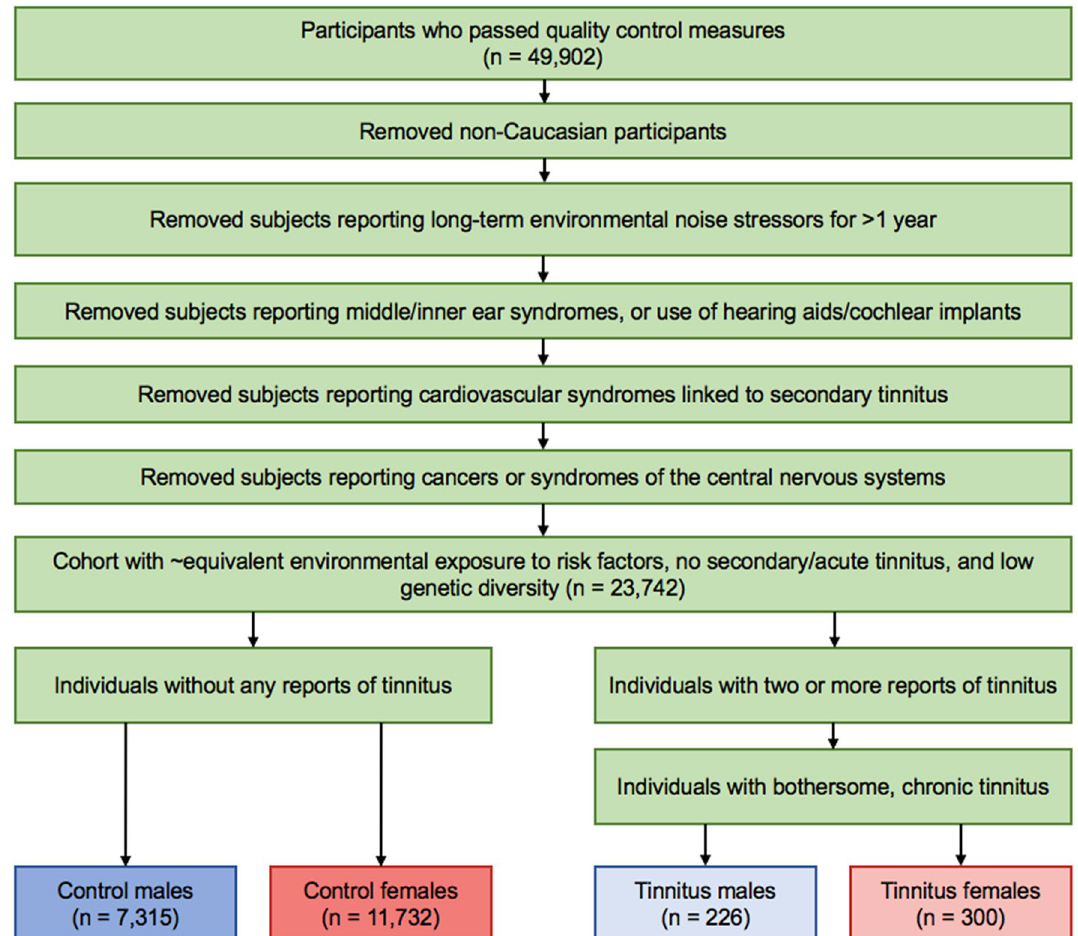
Figure 2. Reductionist workflow of phenotypic sorting measures used to define tinnitus and control cohorts. Participants were screened based for those with chronic, primary, low-threshold, and bothersome tinnitus against those participants never having tinnitus. Of the original 49,902 WES participants, 48,820 had self- reported tinnitus and noise stressor